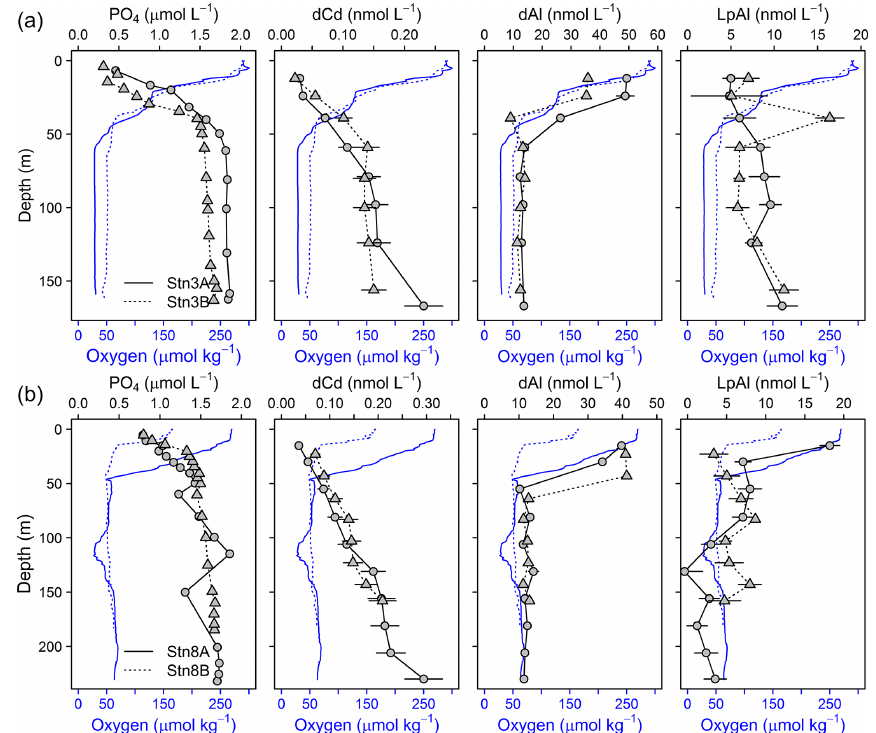
Figure 8. Depth profiles of dCd, PO 4 , dAl, and LpAl of repeat stations. First deployment displayed as solid black line and circles and second deployment displayed as dashed black line and triangles. Oxygen concentrations are indicated as blue solid line for the first deployment and dashed blue line for the second deployment. (a) Station 3 (18.23 ◦ N, 16.52 ◦ W; 170m water depth, 9d between deployments) and (b) station 8 (18.22 ◦ N, 16.55 ◦ W; 189–238m water depth, 2d between